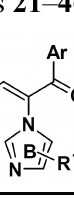
Table 1. Chemical structures of compounds 21 – 46 and their antifungal